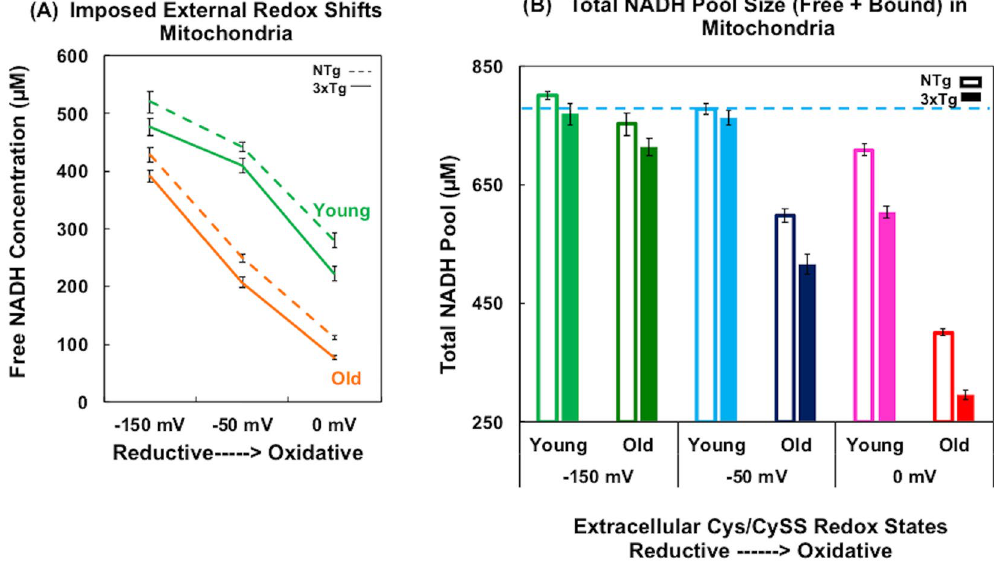
Figure 4. Absolute free NADH concentrations and total NADH pool size shift in mitochondria in response to an imposed external Cys/CySS reductive ( − 150 mV) or oxidative (0 mV) state for young and old age neurons from NTg and 3xTg-AD female mouse brains. ( A ) Under the imposed external oxidative stress, free NADH in mitochondria of both young and old neurons, both genotypes was depleted compared to that of untreated condition at − 50 mV (at 0 mV, NTg young F(1, 31) = 112, p < 0.001; NTg old F(1, 31) = 338, p < 0.001; 3xTg young F(1, 31) = 128, p < 0.001; 3xTg-AD old F(1, 31) = 198, p < 0.001) and was elevated with external reductive state to − 150 mV (at − 150 mV NTg young F(1, 31) = 16, p < 0.001; NTg old F(1, 31) = 154, p < 0.001; 3xTg young F(1, 31) = 13, p = 0.0013; 3xTg-AD old F(1, 31) = 183, p < 0.001) (n = 16 neurons/treatment/ age/genotype). ( B ) Mitochondrial total NADH pool size in each redox state of female of both genotypes. As a reference, the blue dashed line indicates the total NADH pool in young NTg neurons at − 50 mV redox